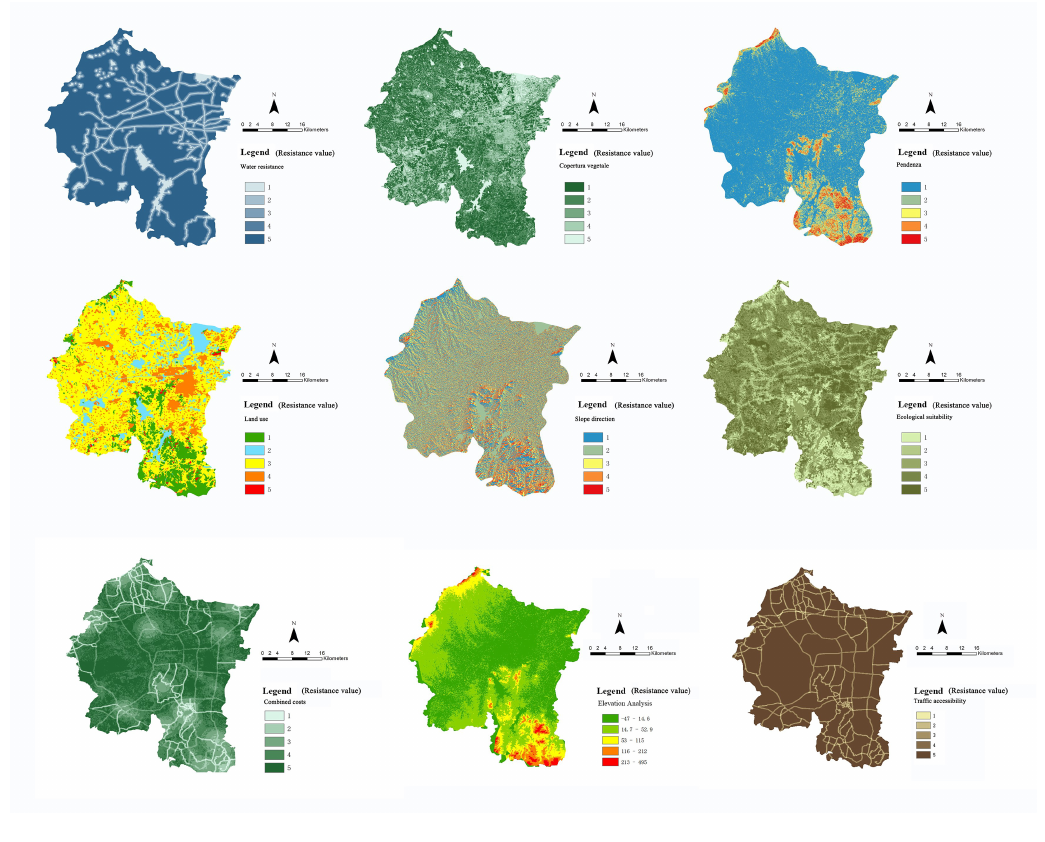
Figure 7. Coupling analysis.